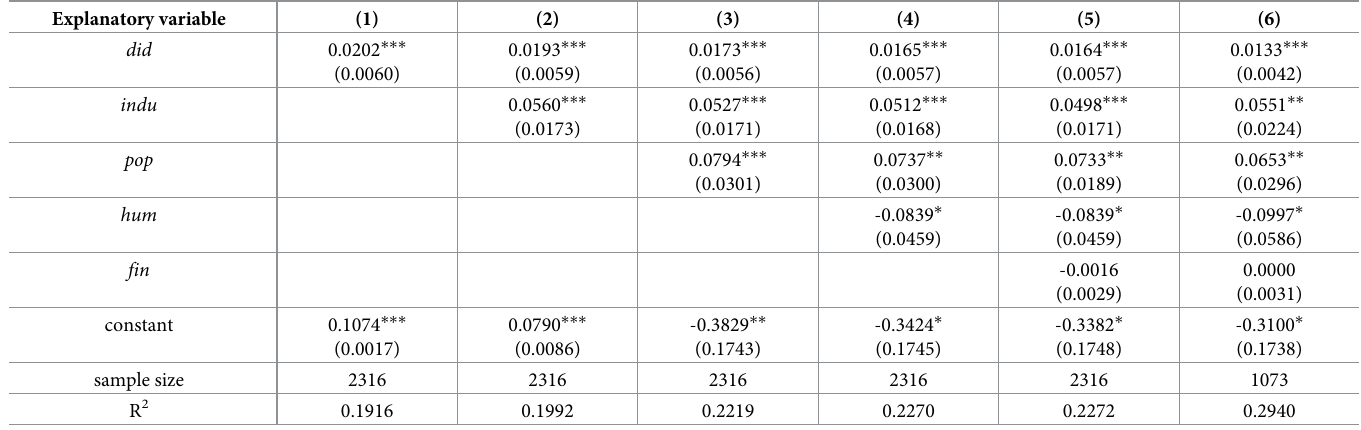
Table 4. Estimation results: Benchmark